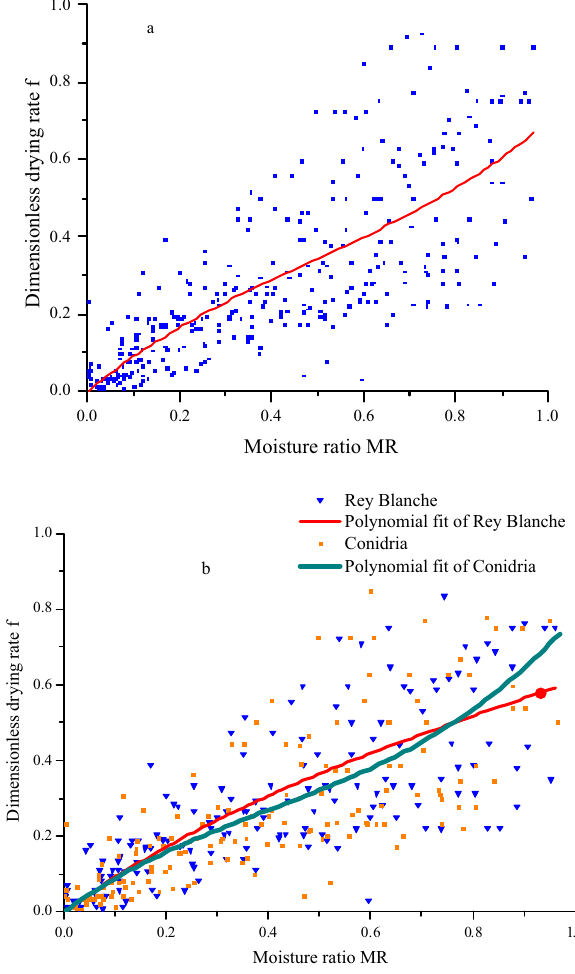
Figure 7. Characteristic drying curve of fig ( a ) and dimensionless drying rate versus moisture ratio of Rey Blanche and Conidria varieties ( b ).